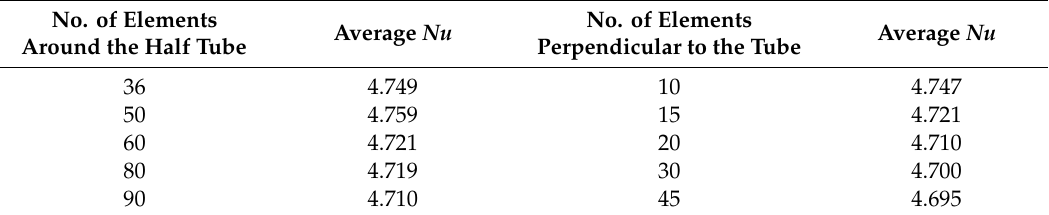
Table 2. Mesh independence test for single cylinder.